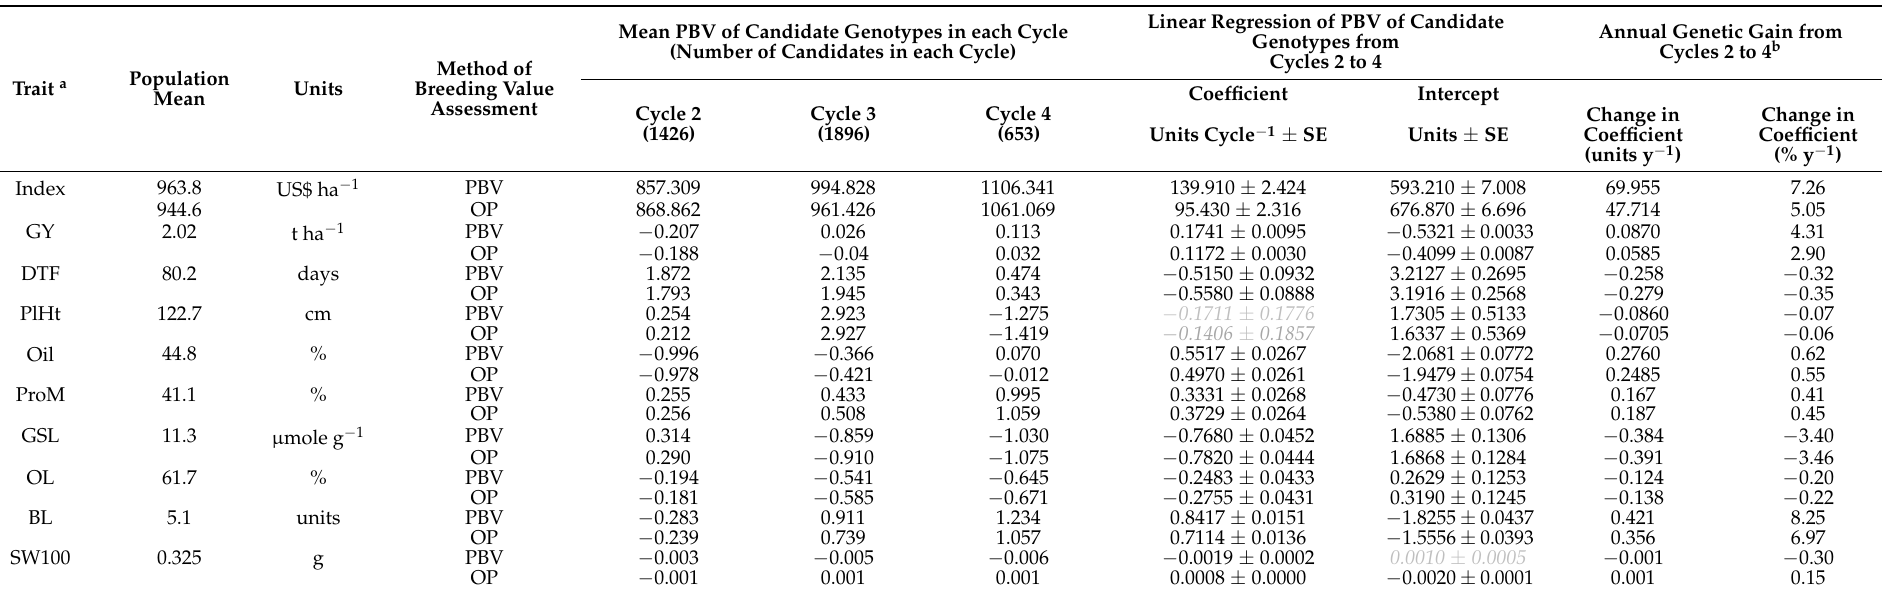
Table 4. Genetic gain in predicted breeding values (PBV) and overall performance (OP) across cycles 2, 3 and 4 for each trait and the economic index. PBV and OP were obtained from the optimum MMM-FA model of the genotype × environment interaction effects (see Table 2). The linear regression coefficient of candidate PBV and OP across cycles 2 to 4 is shown in units cycle − 1 , and annual genetic gain from cycles 2 to 4 as units y − 1 and as % of the population mean y − 1 for each trait. Italicized values of coefficient and intercept in grey were not significant at p =